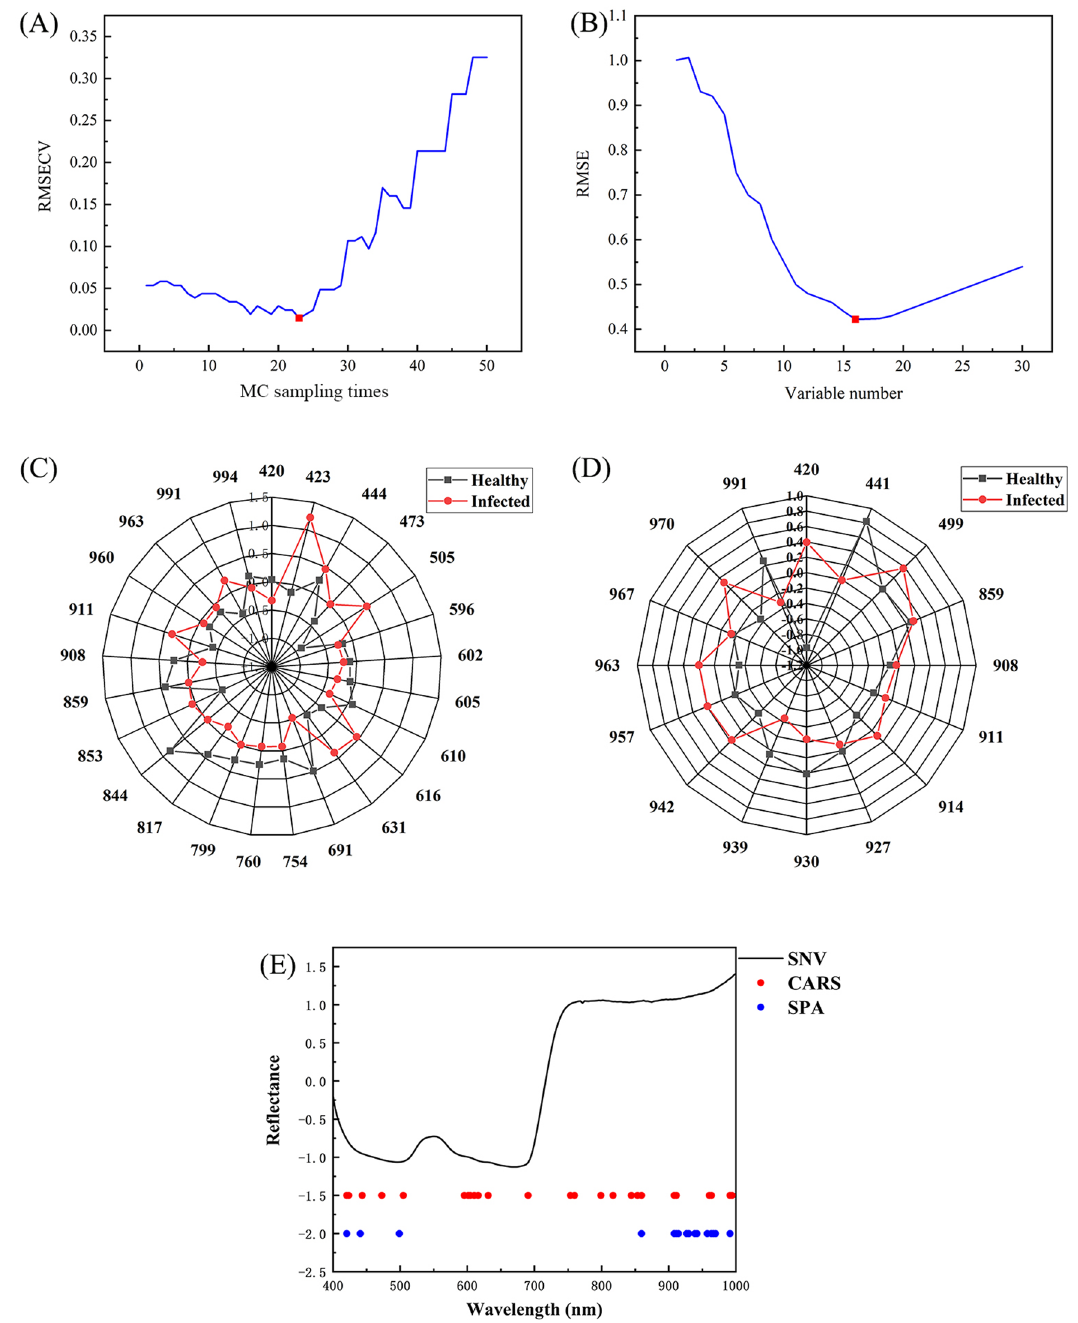
Figure 5. ( A ) MC sampling times versus RMSECV of CARS model. ( B ) Variable number versus RMSE of SPA models. ( C ) Plot of the band scores of healthy vs. infected samples after CARS band screening of the PLS-DA model. ( D ) Plot of the band scores of healthy vs. infected samples after SPA band screening of the PLS-DA model. ( E ) SNV preprocessing-based screening of CARS and SPA CARS and SPA highlighted that the model validation based on CARS was better, with the average accuracy of 87% and the speed increasing by an average of 3.5%. When the CARS-PLS and CARS-SVM models were compared, the accuracy of both was 87%, but CARS-SVM model ran 1.1% faster. Visualization of classification results. Due to the SNV-CARS-SVM model possessing a good perfor- mance stability, fast running speed, and high accuracy, the results of this model were used for visualization to observe tomato S. sclerotiorum infection more intuitively. This model is a binary discrimination model and can- not visualize the degree of leaf infection. Therefore, the probability function of the SVM model was introduced